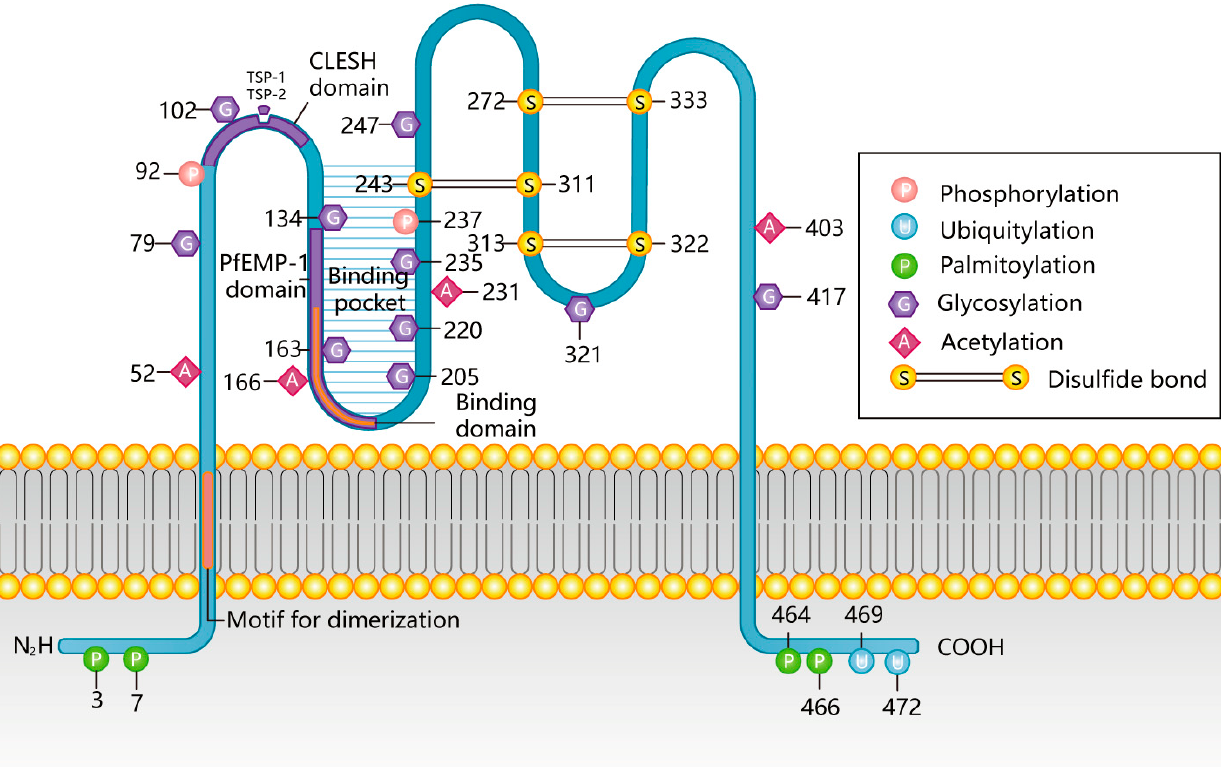
Figure 1. Protein structure of